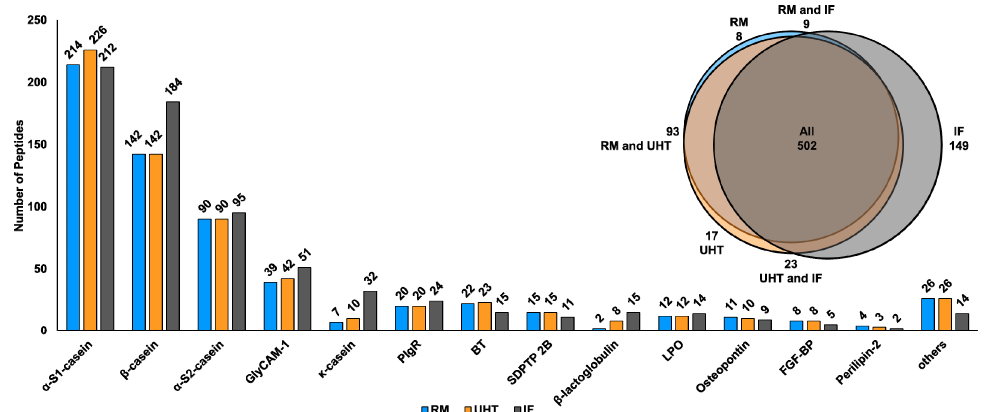
Figure 1. Number of unmodified peptides identified for different proteins in raw milk (RM, blue), ultra-high temperature (UHT, orange) treated milk, and infant formula (IF, grey). The insert shows a diagram displaying the numbers of identified peptides among RM, UHT milk, and IF. Abbreviations: GlyCAM-1—glycosylation-dependent cell adhesion molecule 1, PigR—polymeric